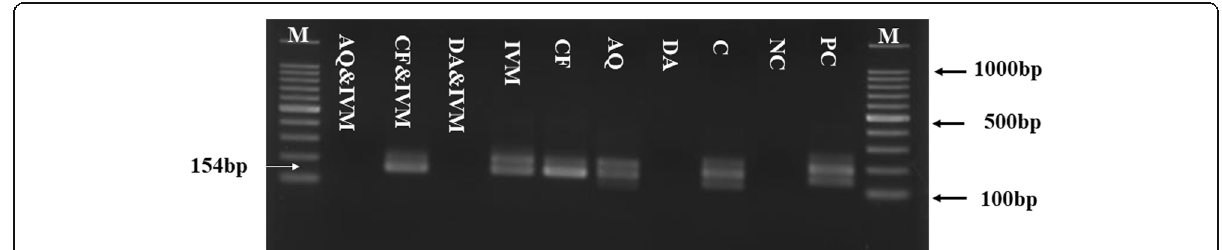
Fig. 6 Molecular detection of parasite DNA in the treated groups . The image shows the molecular detection of parasites in the blood of treated groups on day 49. M is for the marker, NC is for the untreated-uninfected group that was used as a negative control, PC is for the untreated- infected group which used as the positive control, and C is for B . microti DNA control. The arrow shows the expected band length of 154 bp for positive cases of B . microti . The double bands observed with some of the positive controls represent amplicons of the first and second PCR. While a single band was observed in other groups due to the lower parasite DNA